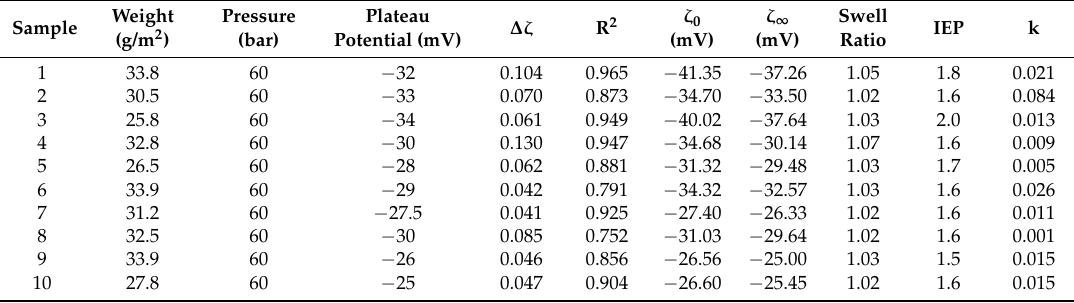
Table 2. Zeta Potentials of Tens Rolls of Nonwoven Fabrics Produced at 60 Bar. Note that Plateau Potential refers to ζ plateau.